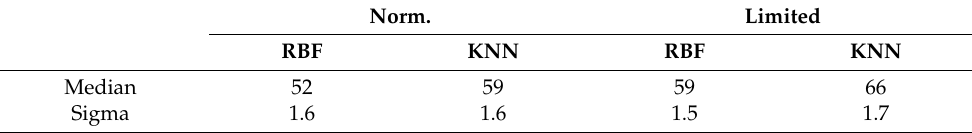
Table 4. F1 score results of the test series with histograms.